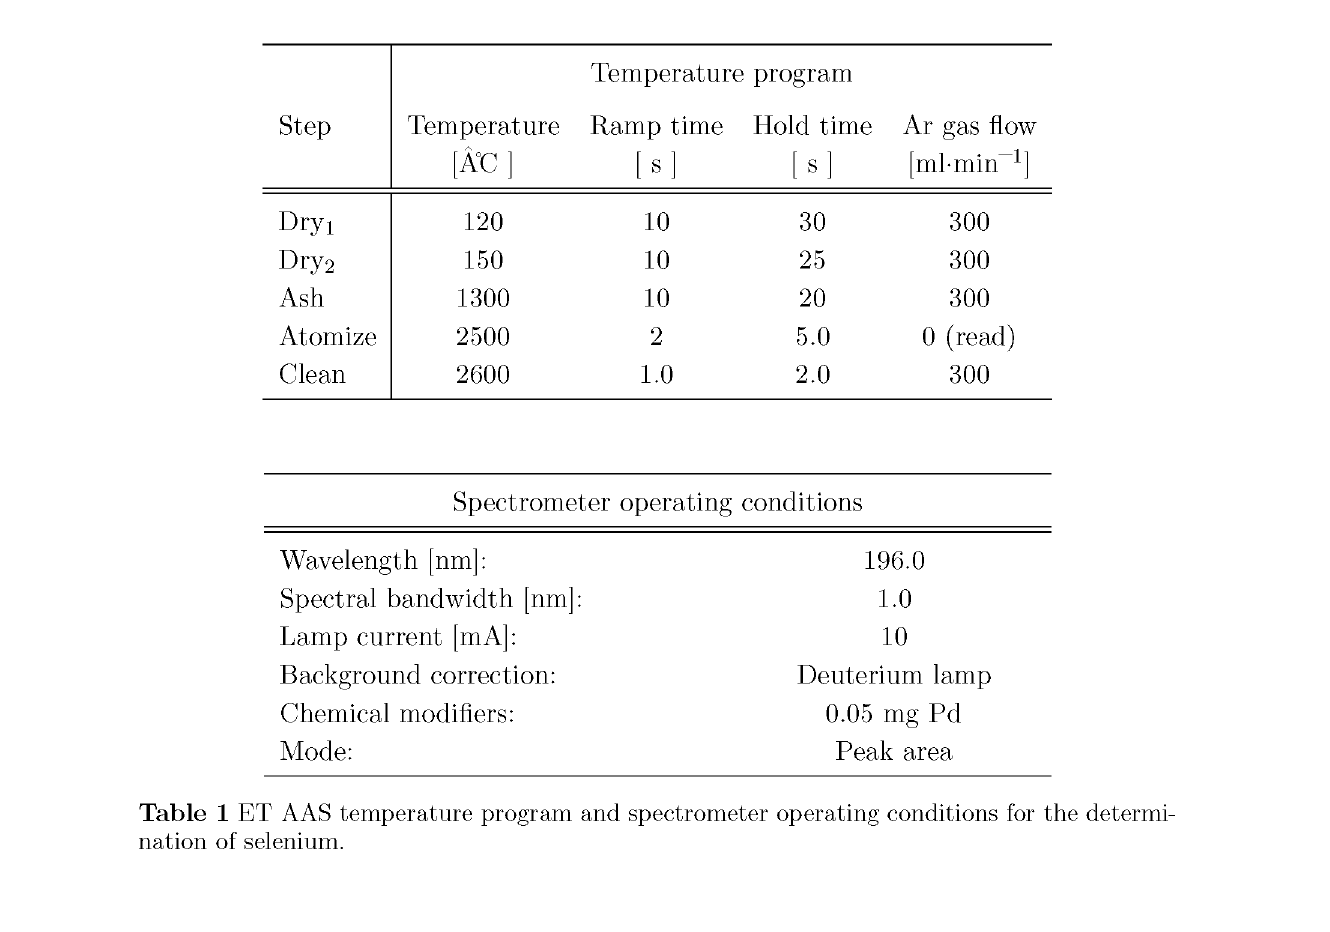
Table 1 ET AAS temperature program and spectrometer operating conditions for the determi- nation of